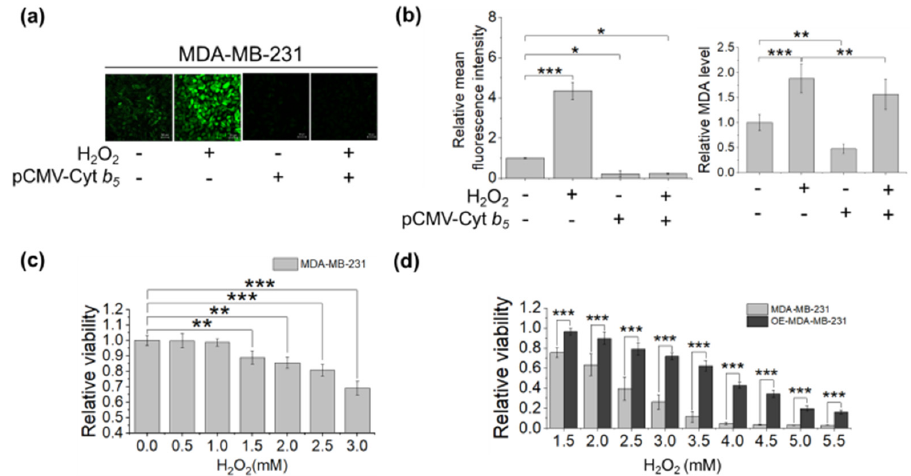
Figure 3. Overexpression of Cyt b 5 in MDA-MB-231 cells and treatment with H 2 O 2 . ( a ) Detected ROS levels in MDA-MB-231 cells by treating with DCFH-DA reagent. ( b ) Analysis of MDA levels in MDA-MD-231 cells by using lipid peroxidation MDA assay kit. ( c ) Analysis of MTT assays in H 2 O 2 -treated MDA-MB-231 cells with 0–3.0 mM H 2 O 2 . ( d ) Analysis of MTT assays in H 2 O 2 -treated MDA-MB-231 cells and H 2 O 2 (1.5–5.5 mM)-treated MDA-MB-231 cells with overexpressed Cyt b 5 . (*) P < 0.05; (**) P < 0.01; (**) P < 0.001